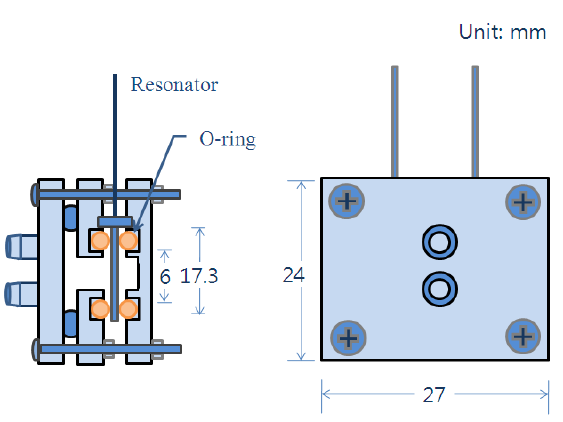
Figure 2. Schematic diagram of the holding cell of quartz crystal microbalance for in-line measurement.